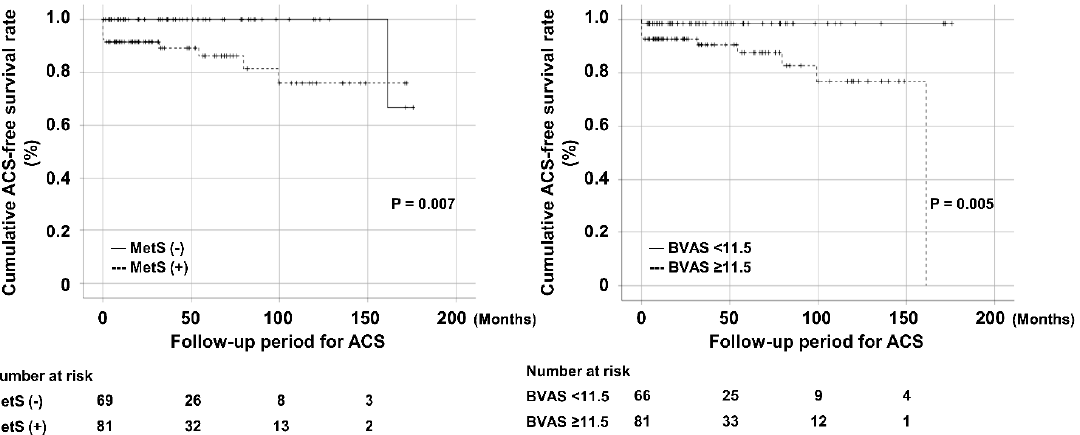
Figure 3. Comparison of cumulative survival rates according to MetS and BVAS. AAV patients with MetS exhibited a significantly lower cumulative ACS-free survival rate than those without MetS, and AAV patients with BVAS ≥ 11.5, exhibited a significantly lower cumulative ACS-free survival rate than those with BVAS < 11.5. MetS, metabolic syndrome; BVAS, Birmingham vasculitis activity score; AAV, ANCA-associated vasculitis; ANCA, antineutrophil cytoplasmic antibody; ACS, acute coronary syndrome.